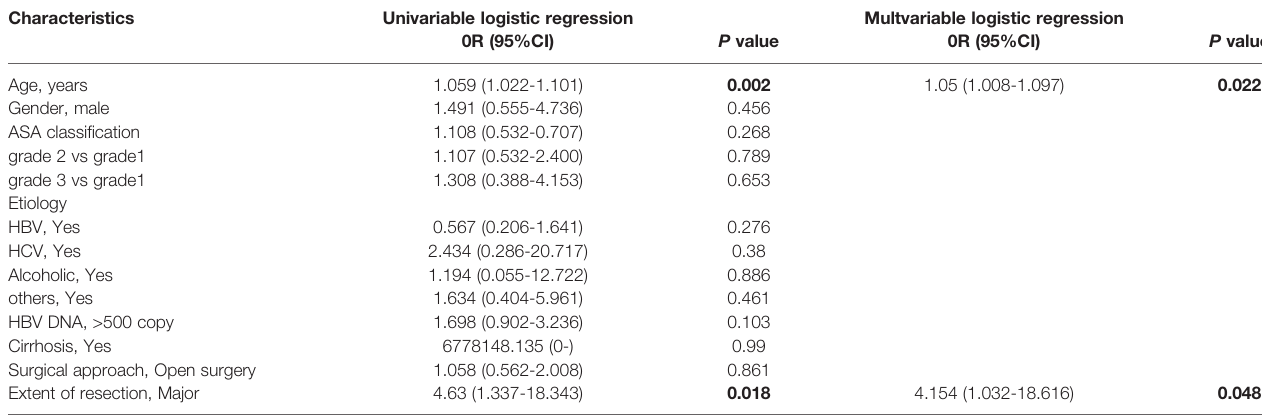
TABLE 4 | Factors Associated with Post Hepatectomy Liver Failure at Univariate and Multivariate Logistic Regression Analyses after Propensity Score Matching.